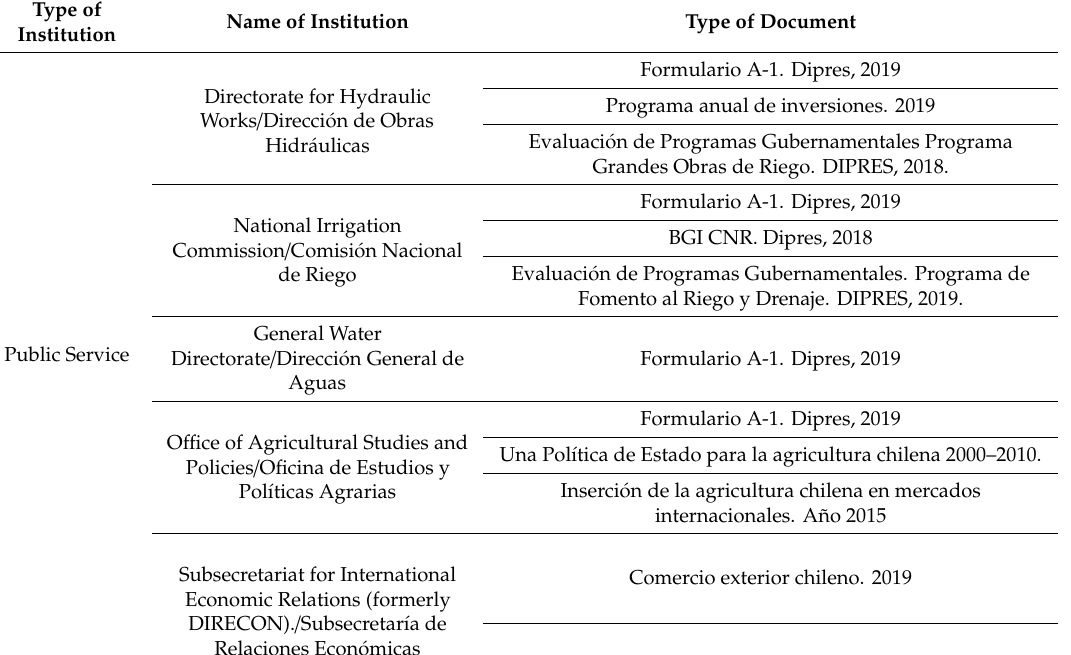
Table A1. Documents analyzed according to type and name of